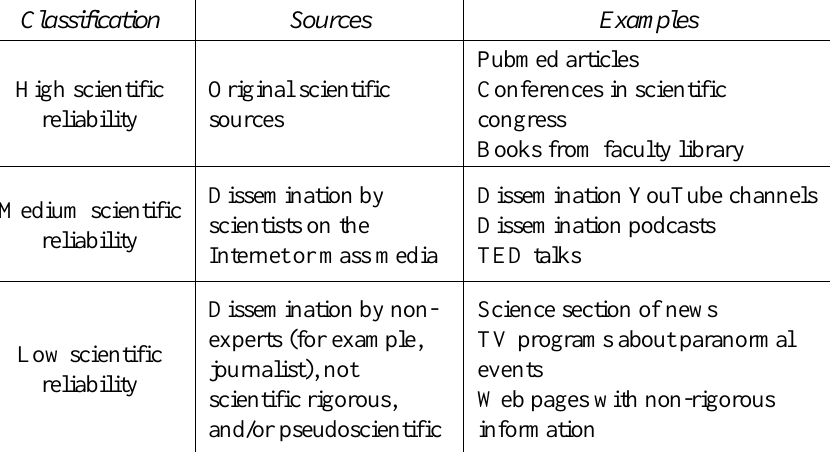
Classification, sources, and examples provided on the Questionnaire on reliable sources of scientific